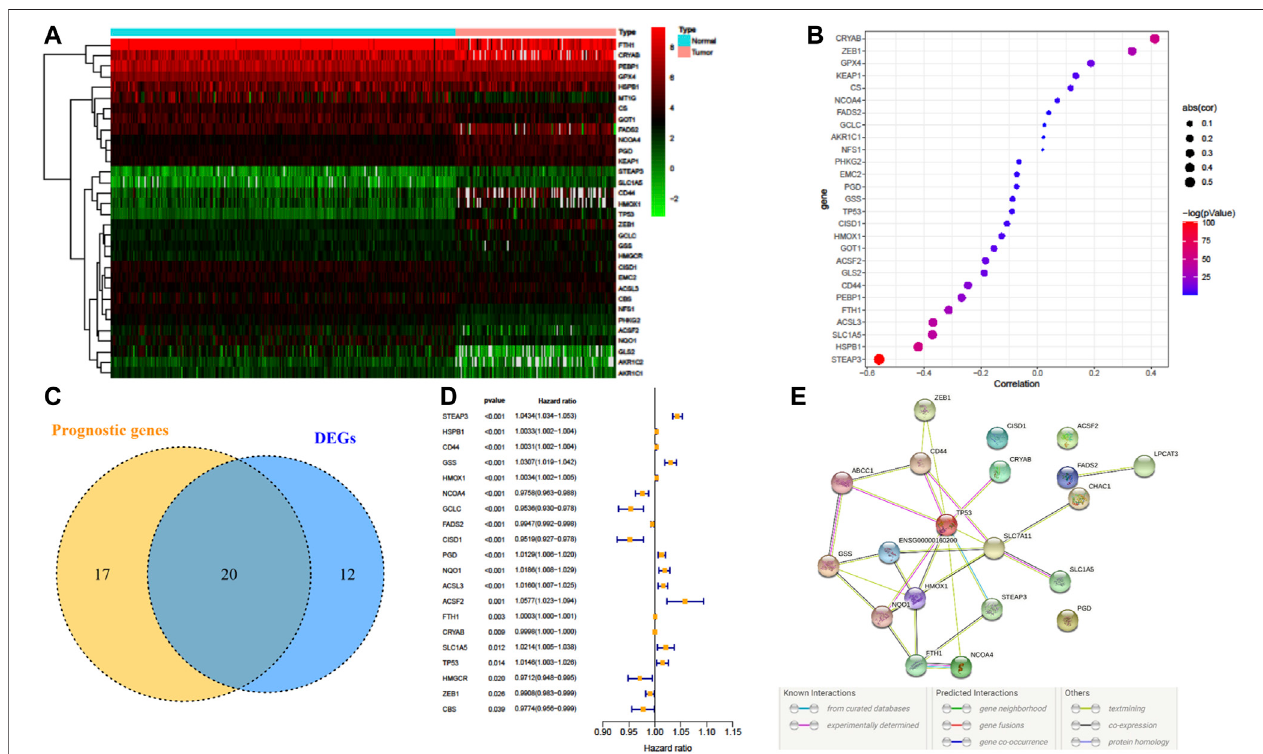
FIGURE 2 | Dysregulation of ferroptosis-related genes (FRGs) and constructing a risk signature. (A) Heatmap of the differentially expressed FRGs between LGG and normal tissue. (B) Pearson ’ s correlation of FRGs between transcriptional expression and promoter methylation. (C) Venn diagram showing the overlapped gene numberofdifferentiallyexpressedFRGsandprognosticFRGsthatcorrelatedwithOS. (D) Forestplotofhazardratiosdemonstratingtheprognosticvalueofoverlapped FRGs. (E) PPI network indicating the interactions among the overlapped